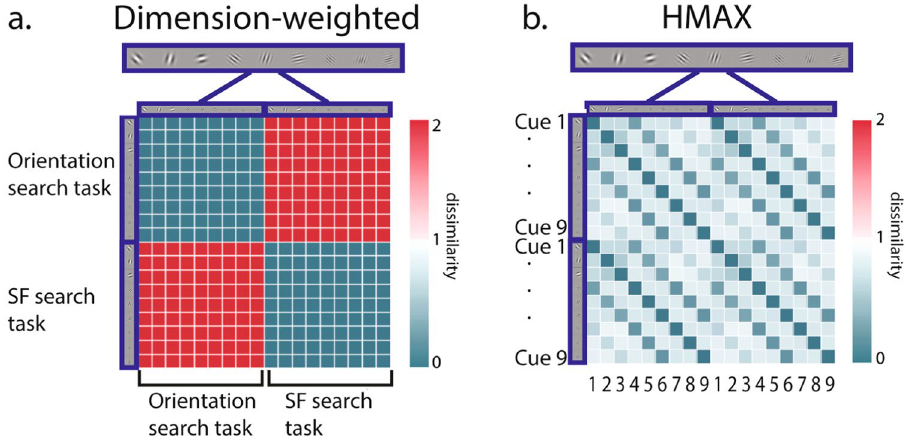
Figure 2. ( a ) The dimension-weighted model RDM, with the cue images represented maximally similarly within the task relevant feature dimension and maximally differently from the task irrelevant feature dimension. ( b ) The HMAX C1 model RDM, representing correlations between simulated visual activity in response to the 9 viewed cue images in the